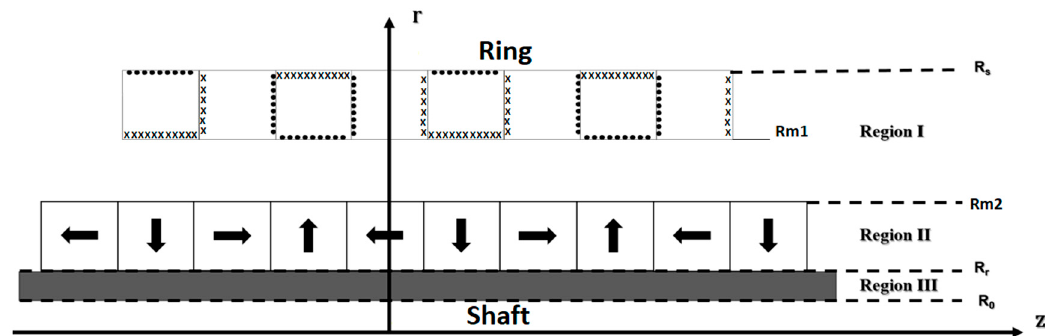
Figure 4. Equivalent MLA system in